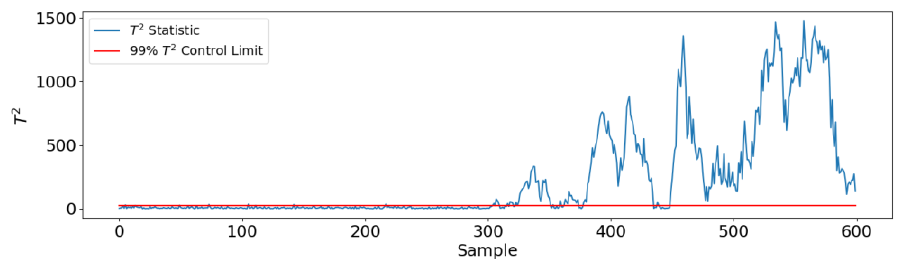
Figure 11. Monitoring results of cointegration analysis with ACE. The blue solid line represents the monitoring statistics, and the red horizontal